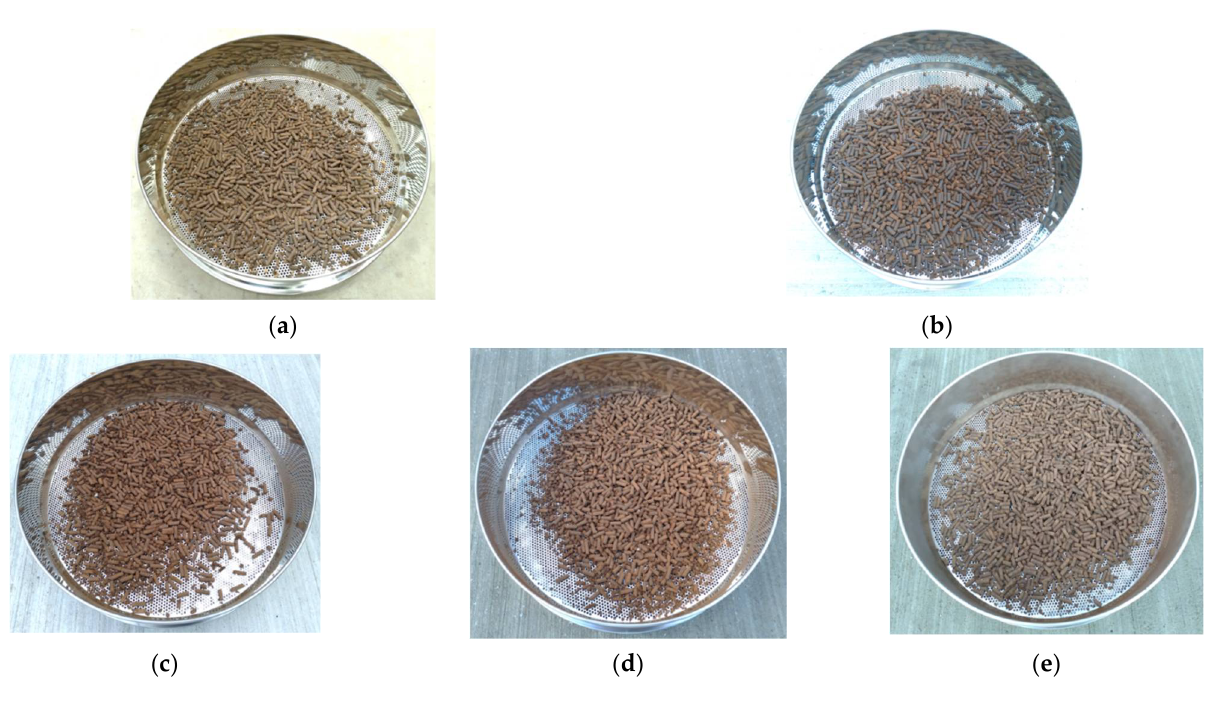
Figure 11. Poplar wood lignin pellets produced using a laboratory-scale pellet mill with ( a ) pure lignin, ( b ) corn oil, ( c ) citric acid, ( d ) glycerol, ( e ) d-xylose.